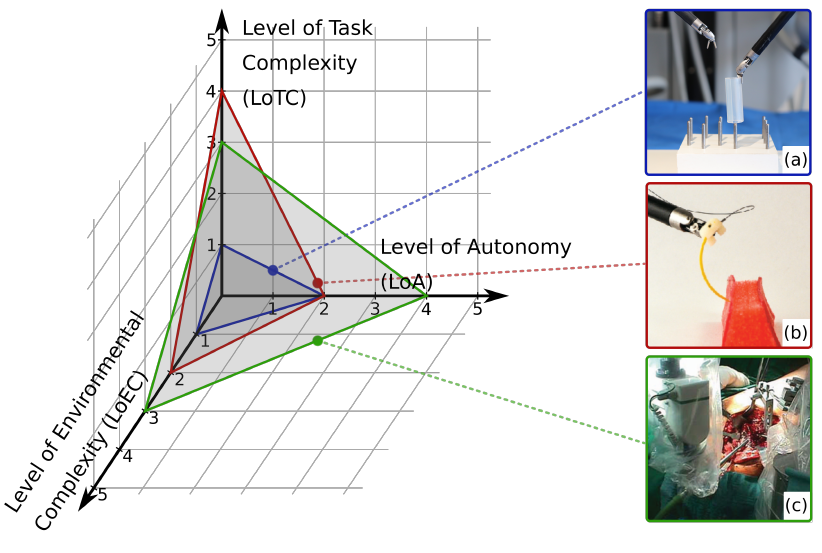
Figure 3. The three-axis model of Surgical Contextual Autonomous Capability (SCAC). The x , y , and z axes represent the key characterizing aspects of autonomous surgical applications: Level of Autonomy (LoA), Level of Environmental Complexity (LoEC), and Level of Task Complexity ((LoTC), respectively. The characterization of three example applications are illustrated: ( a ) autonomous peg transfer surgical training exercise [22] (grading LoA 2; LoEC 1; LoTC 1); ( b ) autonomous multi-throw multilateral surgical suturing [17] (LoA 2; LoEC 2; LoTC 3); ( c ) autonomous bone drilling for total hip replacement surgery , performed by the ROBODOC system (CUREXO INC., Seoul, Korea) [38] (grading LoA 4; LoEC 3; LoTC